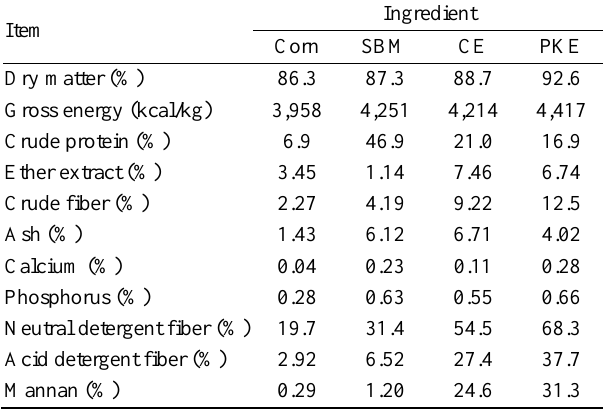
Table 1. Energy and nutrient composition of corn, soybean meal (SBM), copra expellers (CE), and palm kernel expellers (PKE), as-is basis